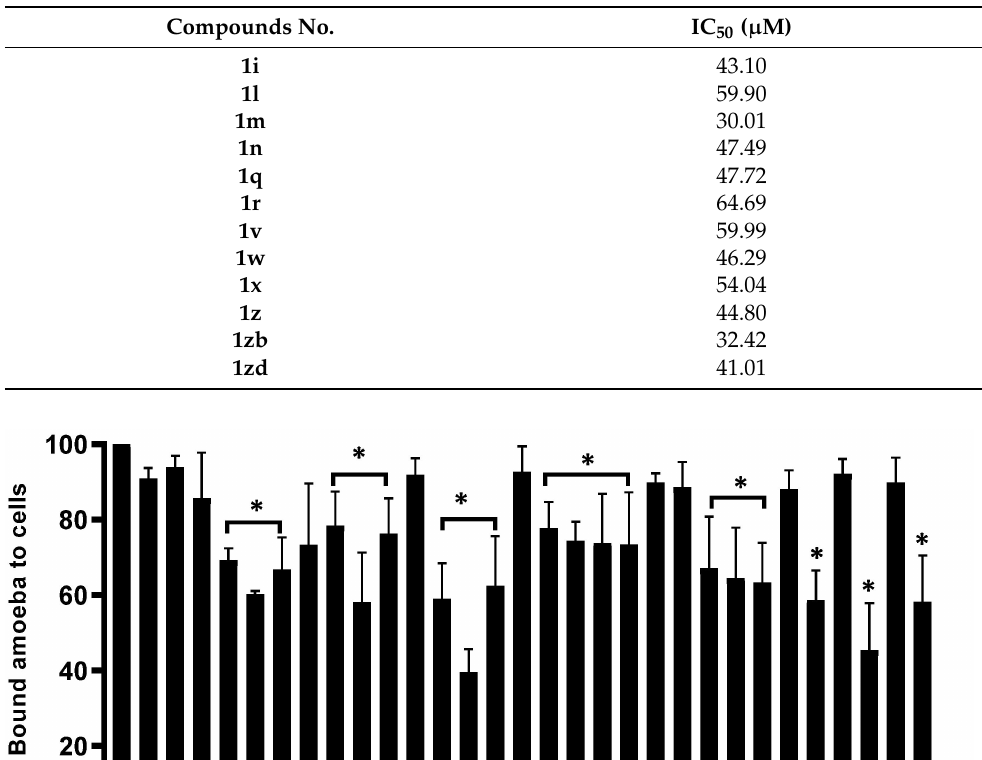
Table 1. Compounds presented 50% inhibitory concentration (IC 50 ) at µ M concentrations.